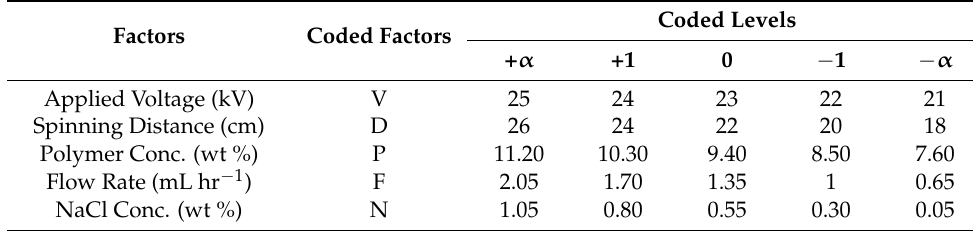
Table 2. The factors and associated levels for experimental design.